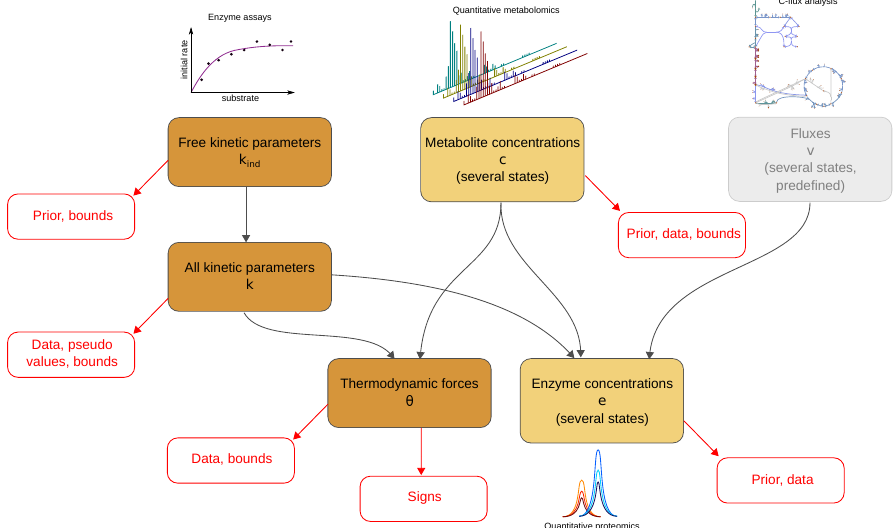
Figure 1. Model balancing relies on a dependency schema for kinetic constants and state variables. All kinetic constants are described in logarithmic scale. A subset of kinetic constants determines all other kinetic constants through linear relationships. If kinetic constants, metabolite concentrations, and fluxes are known, the enzyme concentrations can be computed from rate laws and fluxes: each enzyme concentration is a convex function of the (logarithmic) kinetic constants and metabolite concentrations. The signs of thermodynamic forces are constrained by the flux